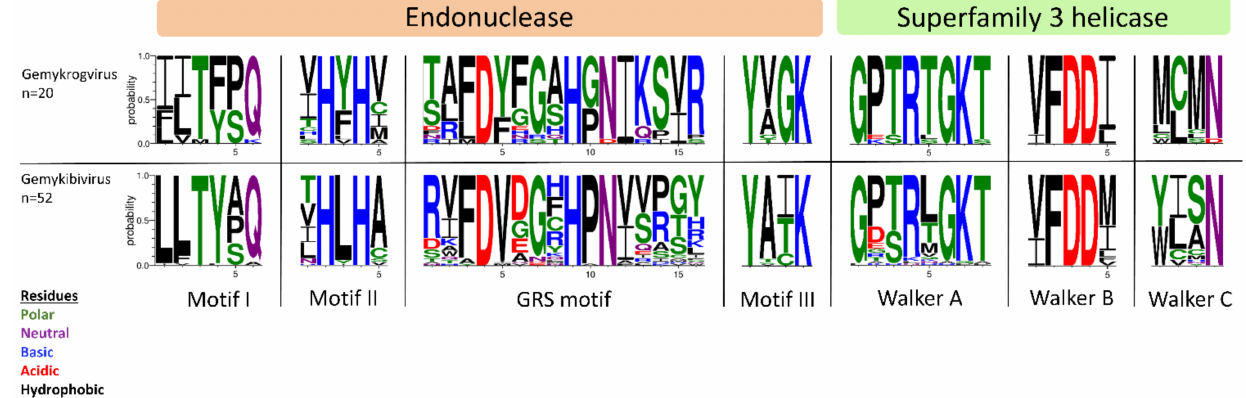
Figure 3. Illustration of amino acid variations in conserved Rep motifs using WebLogo3 [50]. Reps of ICTV-listed gemykrog- and gemykibiviruses as well as from the nine genomoviral isolates identified herein have been included in the